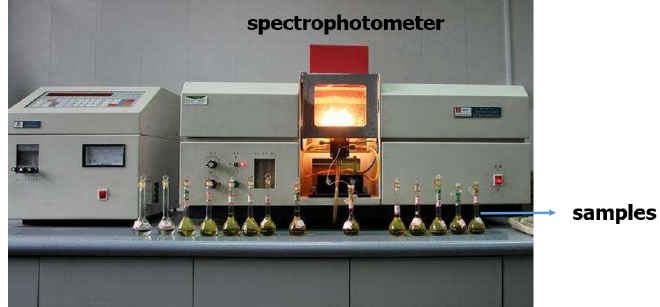
Figure 4. Schematic diagram of spectrophotometer and samples.